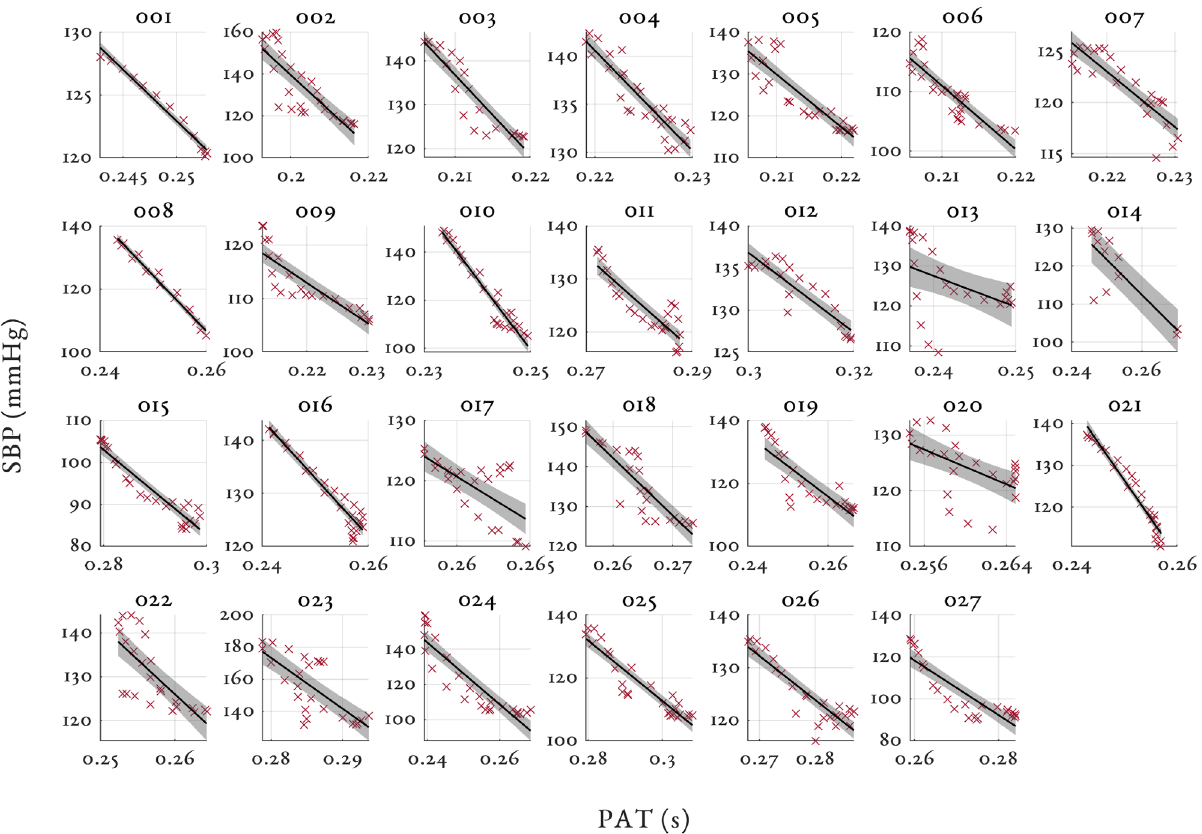
range of BP values for the y-axis (80 mmHg for subject 024, and 10 mmHg for subject